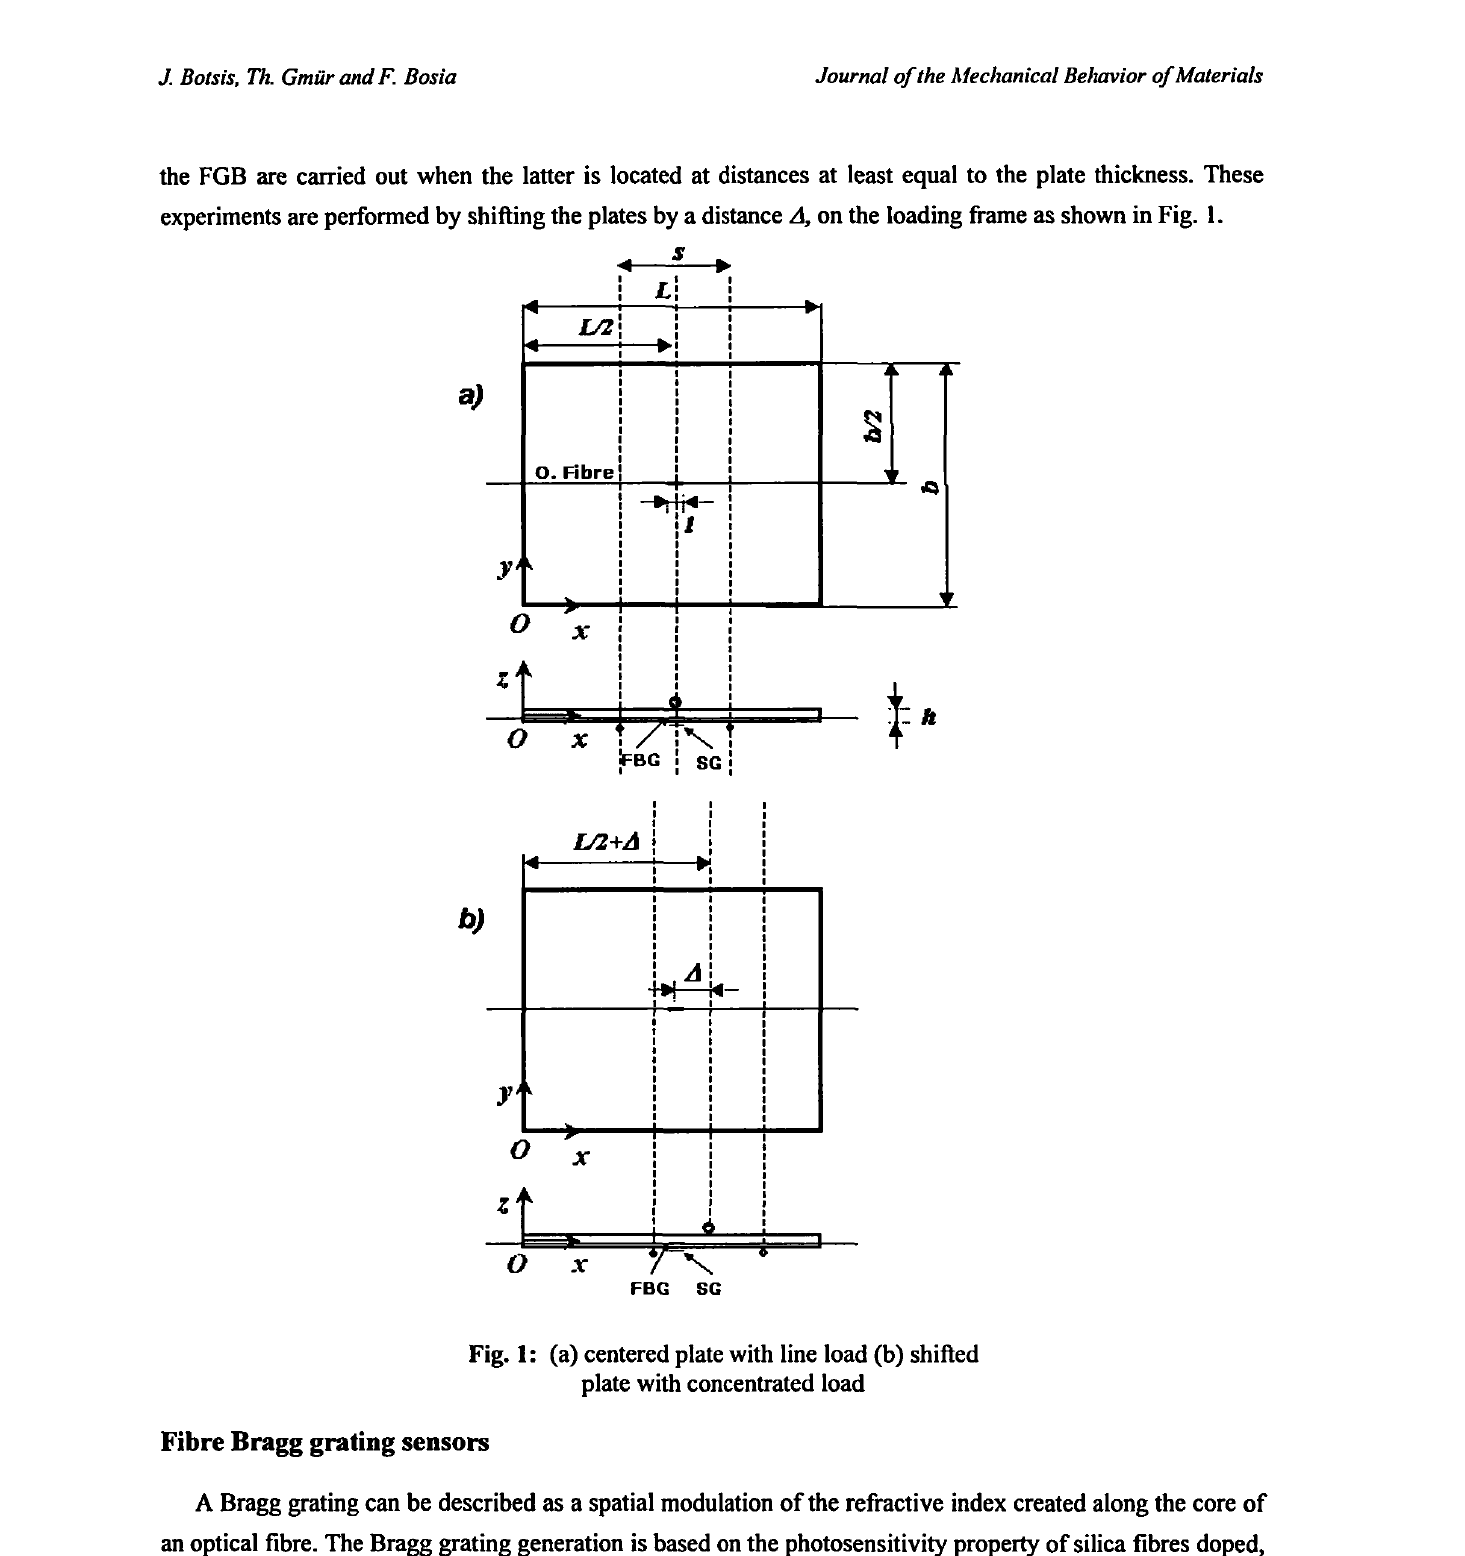
Fig. 1: (a) centered plate with line load (b) shitted plate with concentrated